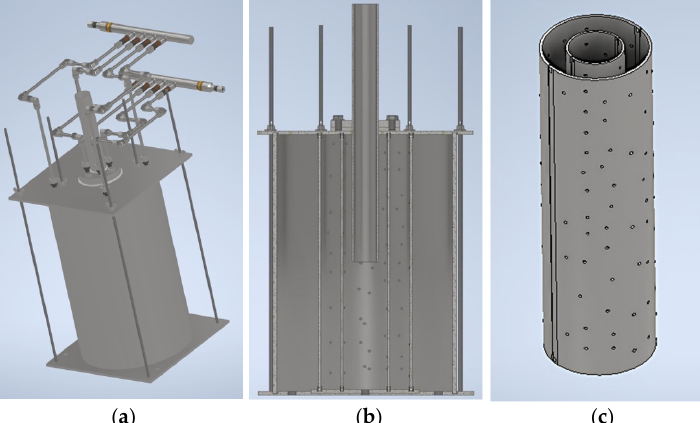
Figure 11. Working area of the stand. ( a ) Connecting the distribution manifold to the work area; ( b ) axial section of the working area; and ( c ) perforated chamber. The hydraulic connection between the brine and drilling fluid supply lines and the working area is through a distribution manifold, shown in Figure 11c.